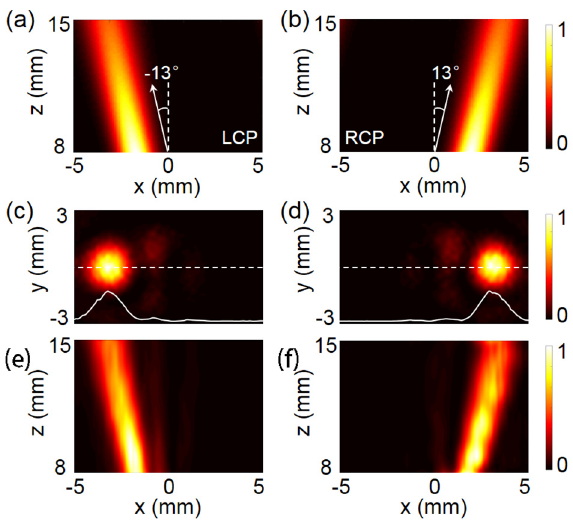
Figure 3. THz far-field intensity distributions: ( a , b ) Simulation results in the xz -plane under ( a ) LCP and ( b ) RCP incidence. ( c , d ) Measured results in the xz -plane and xy -plane ( z = 15 mm) under ( c ) LCP and ( d ) RCP incidence, ( e,f ) Simulation results in the xz-plane under ( e ) LCP and ( f ) RCP incidence. The white solid curves show the horizontal intensity distribution along the white dashed lines.